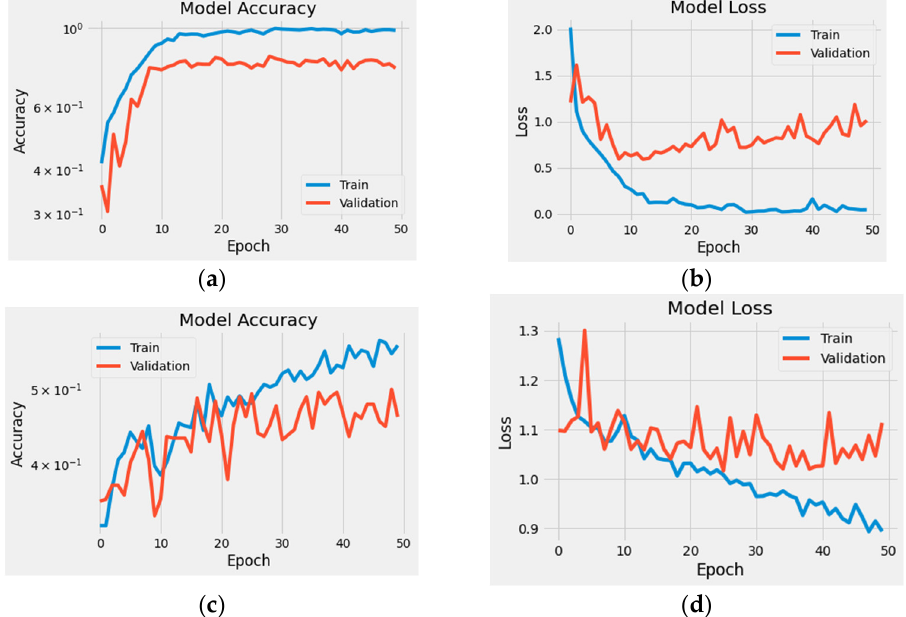
Figure 13. Proposed Deep Learning Models for Multi-class Scenario Learning and Performance Curves. ( a ) Accuracy of 1D CNN. ( b ) Loss of 1D CNN. ( c ) Accuracy of C-CNN. ( d ) Loss of C-CNN.